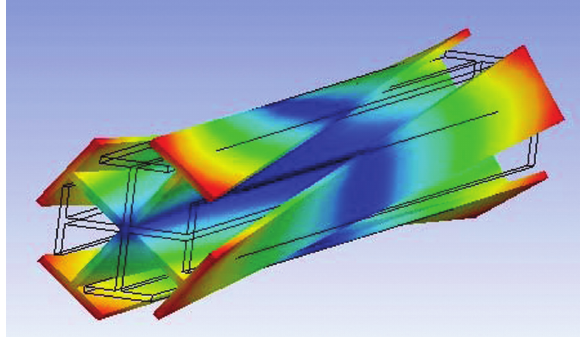
Figure 6 Buckling mode shapes of stiffened cruciform-shaped section for L = 3000 mm (torsional buckling).